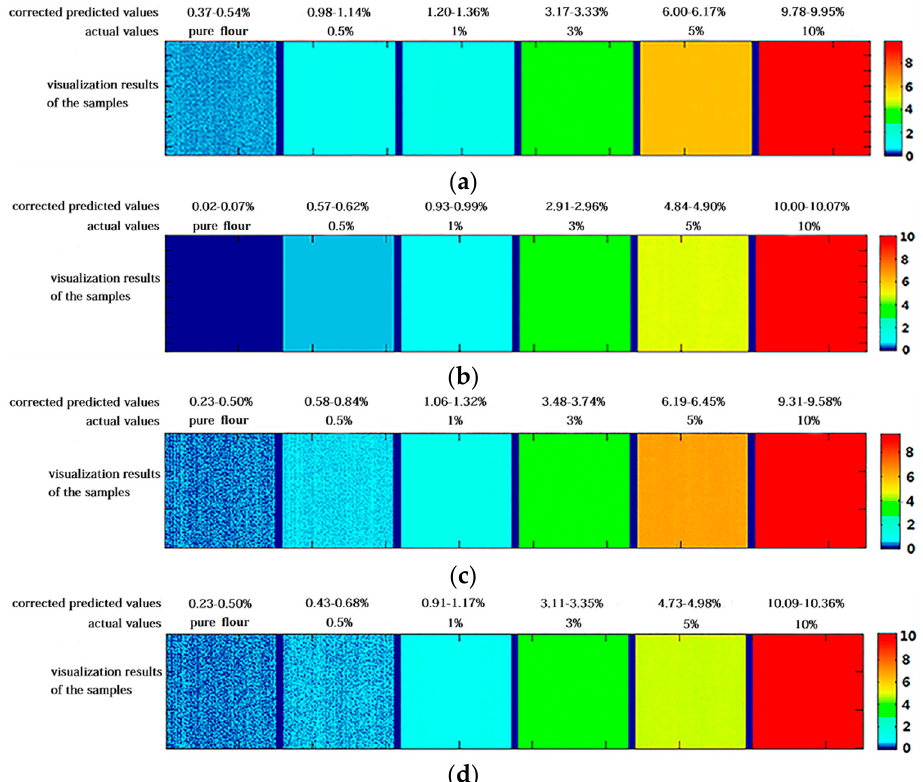
Figure 6. Visualization maps of the corrected predicted values based on multispectral PLSR models for predicting ( a ) peanut contaminant using the 16 wavelengths; ( b ) walnut contaminant using the 14 wavelengths, and the general multispectral PLSR model for predicting ( c ) peanut and ( d ) walnut contaminant using the 17 wavelengths.